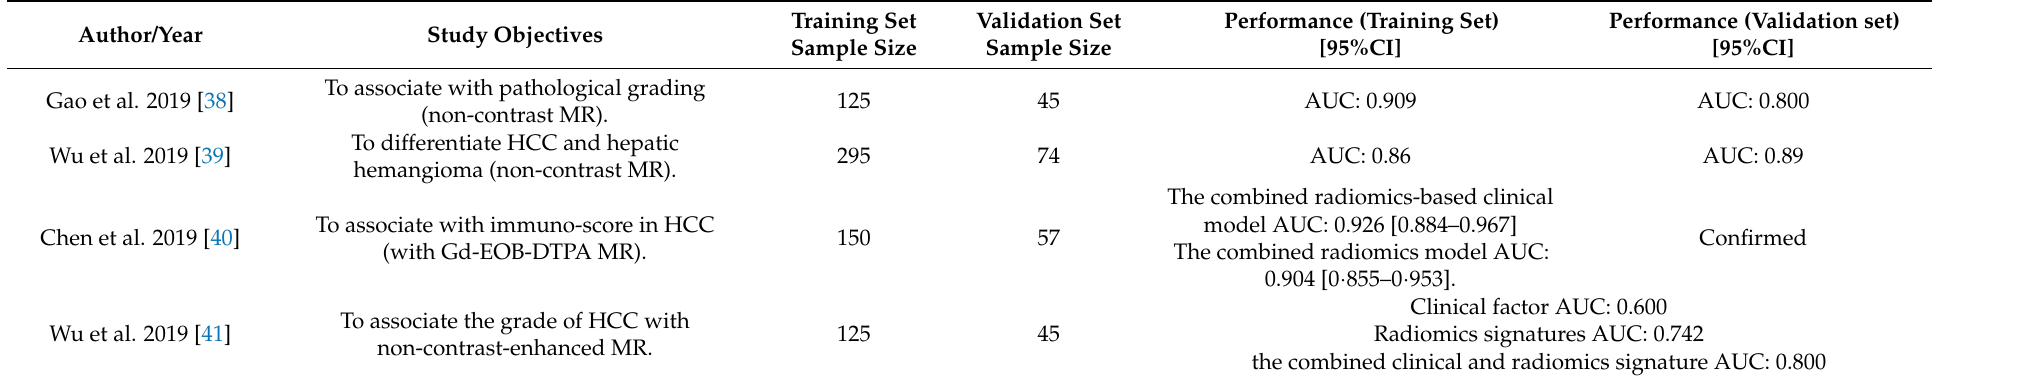
Table 5. Performance of radiomics approaches (MR underlying